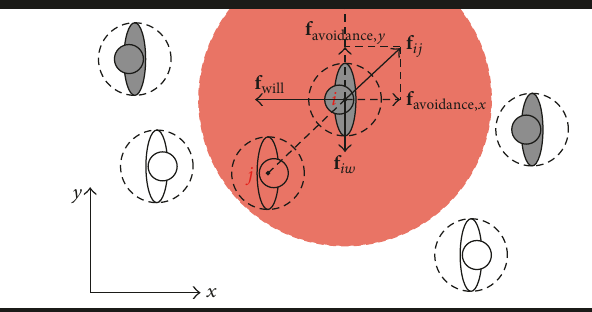
Figure 6: Force analysis of the pedestrian collision-avoidance process in the original social force